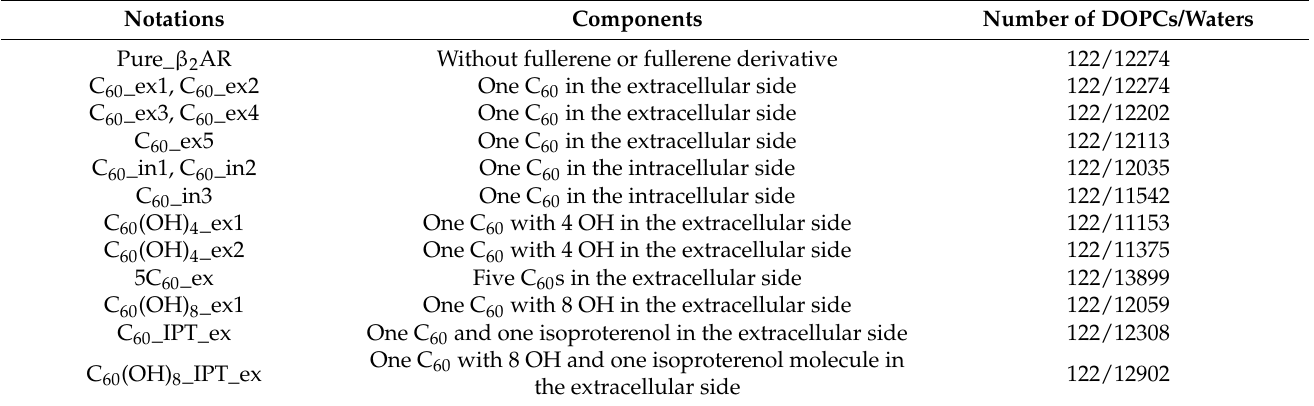
Table 1. Details of the constructed complex systems composed of fullerene, fullerene derivatives and β 2 AR, with the 122 DOPC lipids and different numbers of water